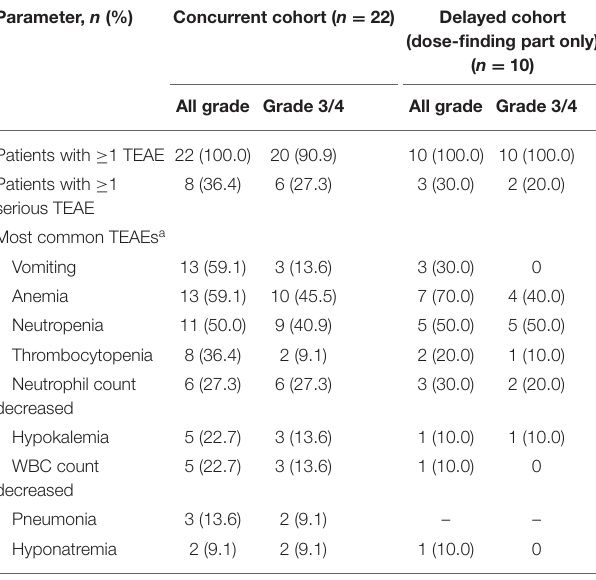
TABLE 2 | Safety outcomes, including most common